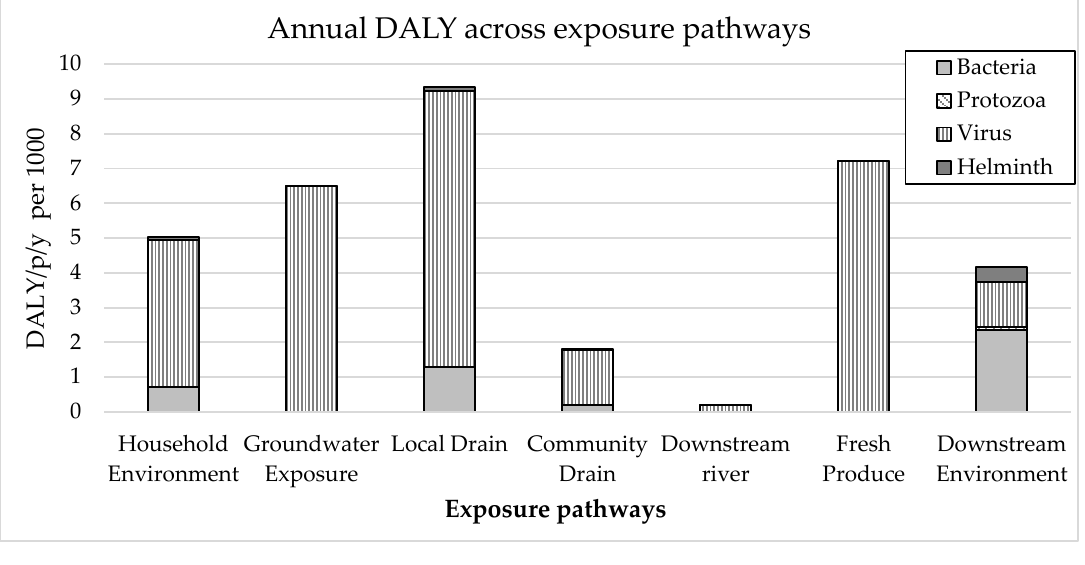
Figure 5. Illustrative output from the base case highlighting the significant pathways and relative contribution to health risk of different pathogens in each pathway.